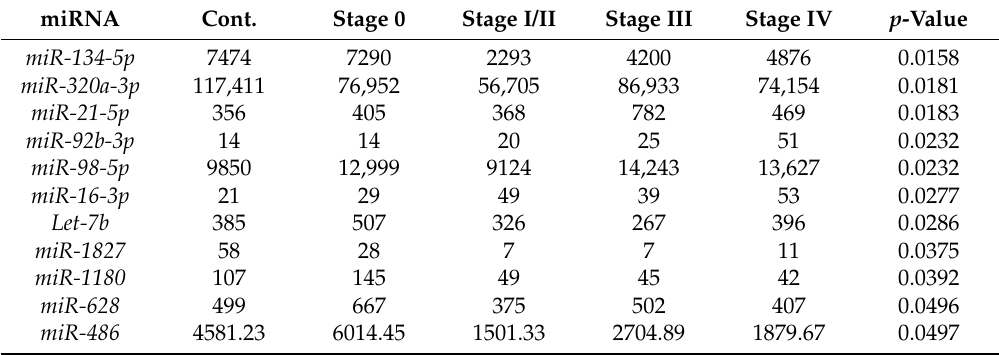
Table 2. Differentially expressed microRNAs (miRNAs) ( p < 0.05). Counts were normalized per million reads. miRNAs validated are depicted in